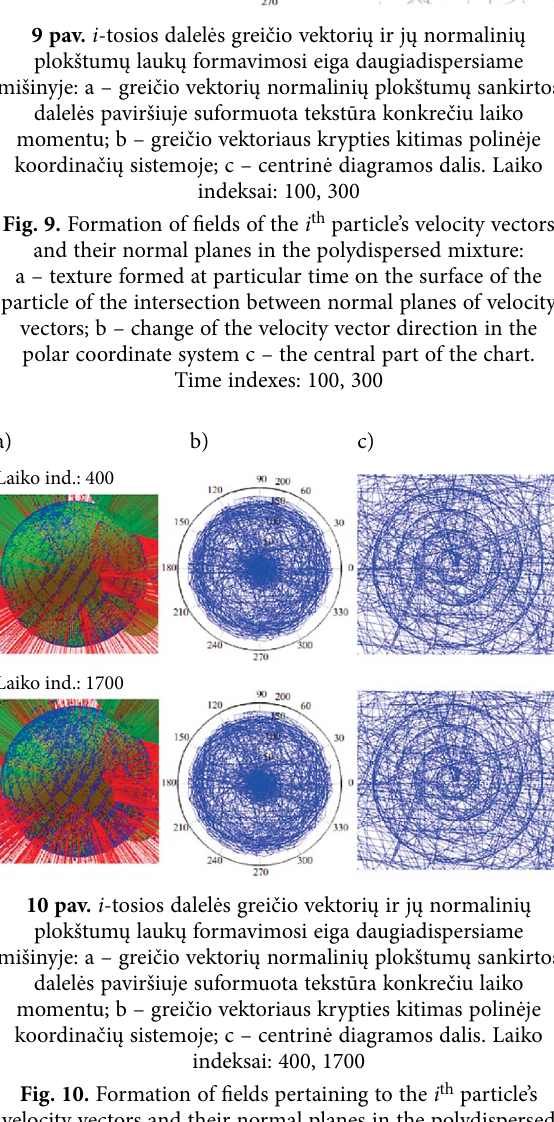
Fig. 8. Formation of fields pertaining to the i th particle’s velocity vectors and their normal planes in the polydispersed mixture: a – texture formed at particular time on the surface of the particle of the intersection between normal planes of velocity vectors; b – change of the velocity vector’s direction in the polar coordinate system. Time indexes: 50, 70, 80